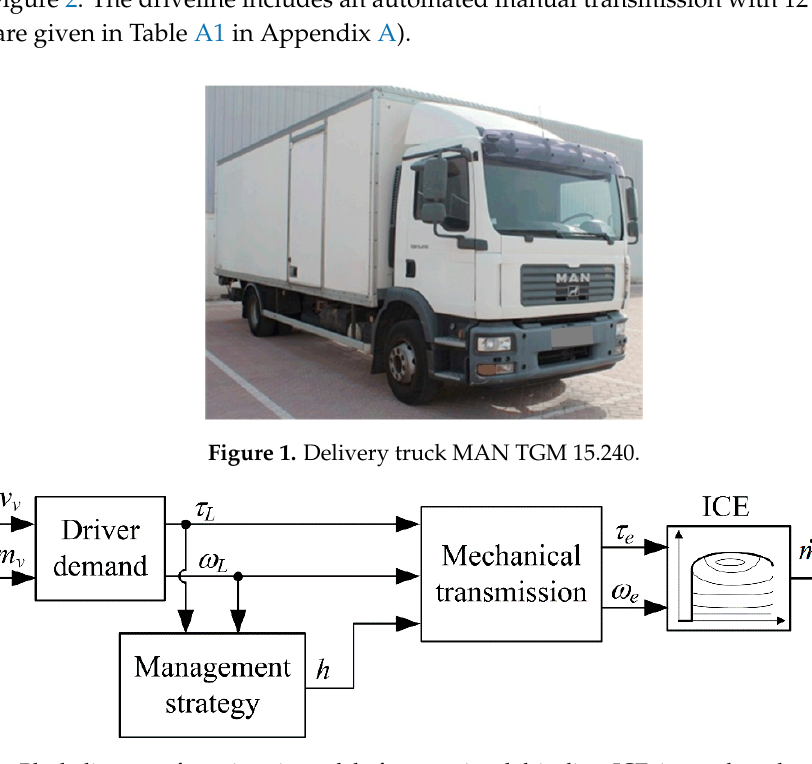
Figure 2. Block diagram of quasi-static model of conventional driveline. ICE: internal combustion engine.